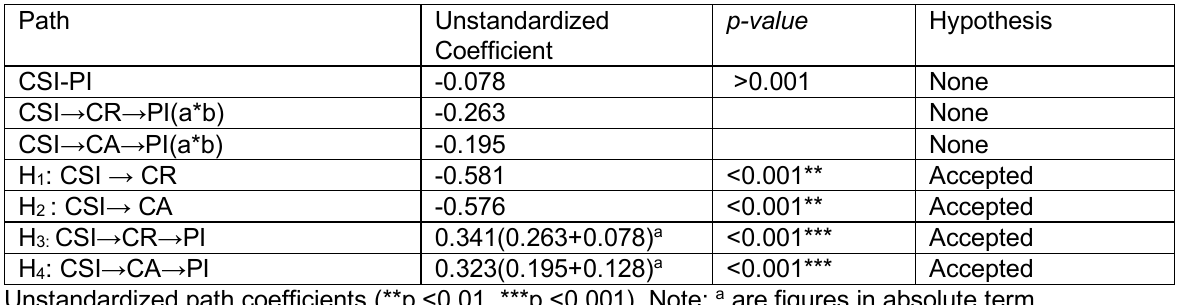
Table 8: Summary of Relationships and Hypothesis